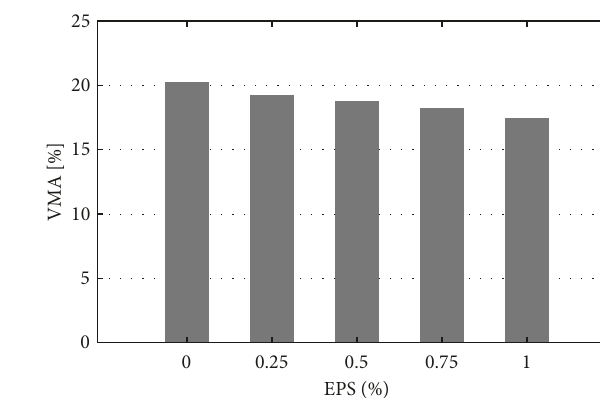
Figure 14: Relationship between VMA and EPS.